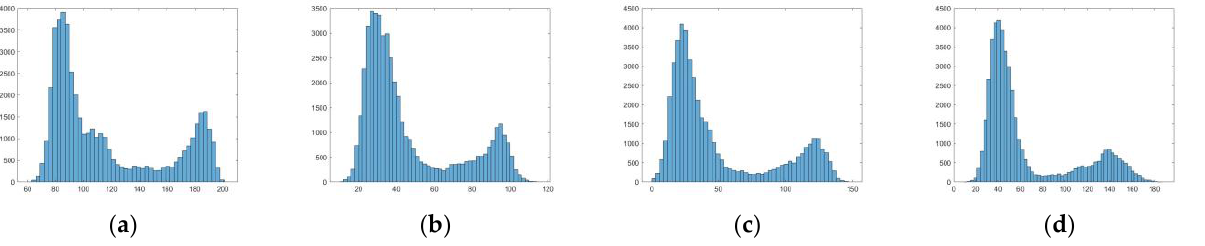
Figure 9. Histogram comparison results, ( a ) result of the original hazy images, ( b ) result of dark channel, ( c ) result of SIDMP, ( d ) result of proposed method.